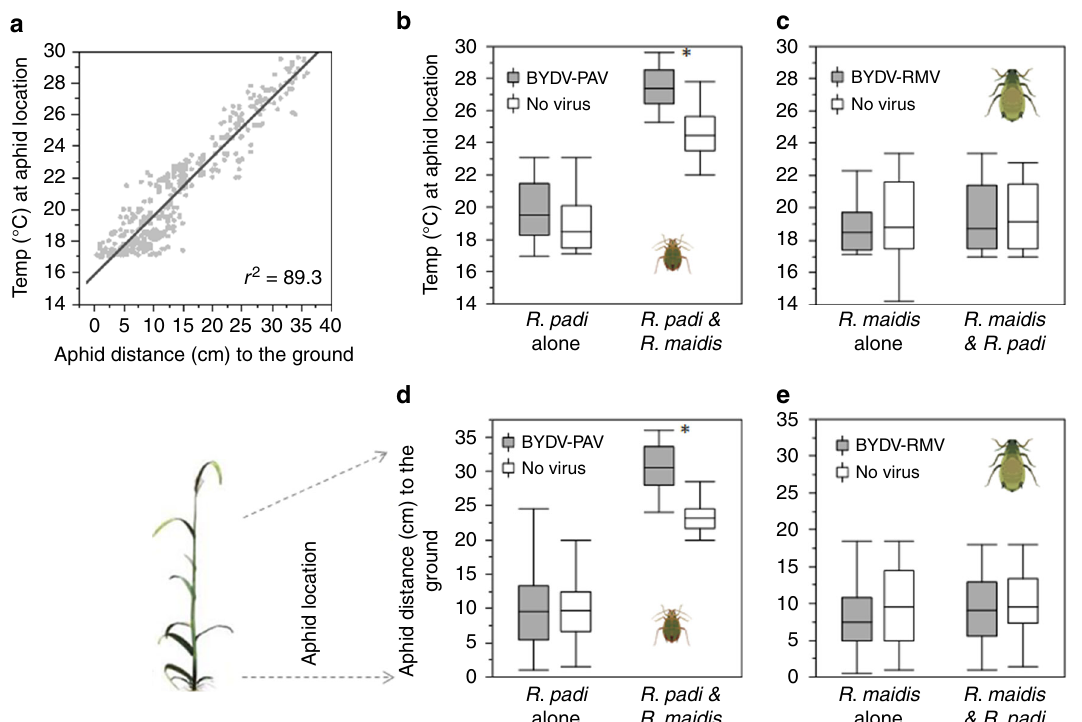
Fig. 2 Aphid spatial distribution on infected and uninfected plants in the fi eld for both aphid species. a Correlation between plant temperature and plant height. b , c Temperature at the location occupied by each aphid species, when occurring alone or together, on plants infected by BYDV-PAV ( b ) and BYDV-RMV ( c ). d , e Distance to ground for locations occupied by each aphid species, when occurring alone or together, on plants infected by BYDV-PAV ( d ) and BYDV-RMV ( e ). Nonparametric ANOVA, Kruskal – Wallis (boxplots display median line, interquartile range (IQR) boxes, 1.5 × IQR whiskers; n = 10 plants per treatment), * p < 0.05. Source data are provided as a Source data fi le.